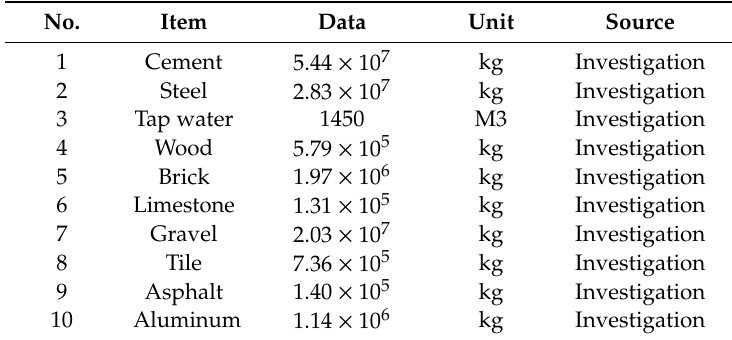
Table 2. main building materials types.